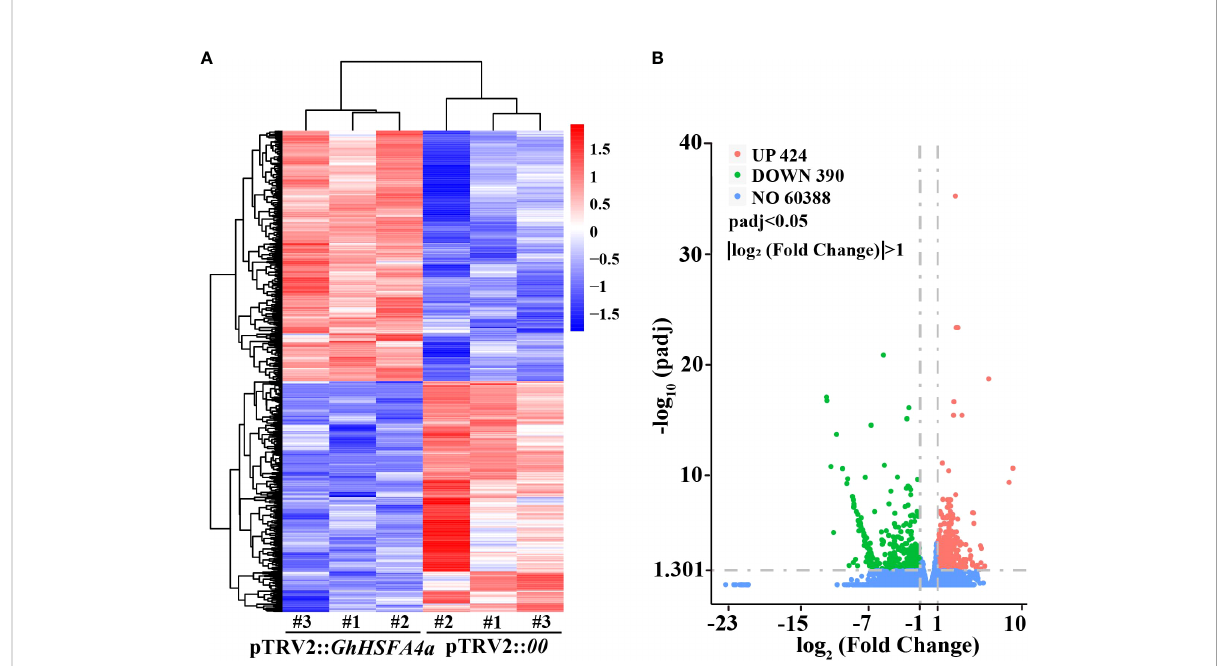
FIGURE 5 Analysis of DEGs between the transcriptomes of pTRV2:: 00 and pTRV2:: GhHSFA4a cottons. (A) Heat map of DEGs in each sample. (B) Volcano map of